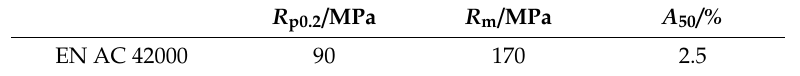
Table 2. Requested mechanical properties of AlSi7Mg alloy separately cast samples in as-cast state